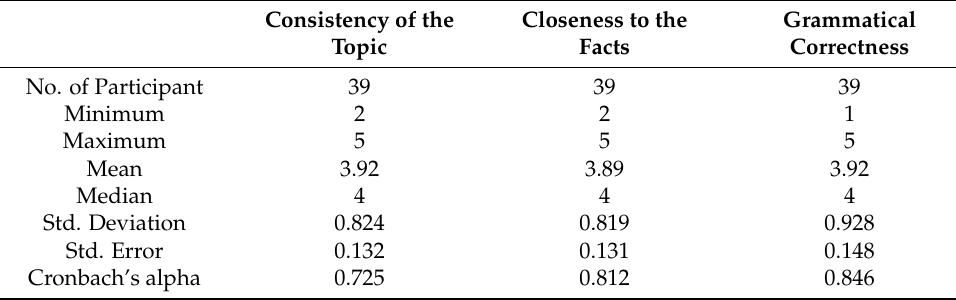
Table 7. Quality assessment of generated